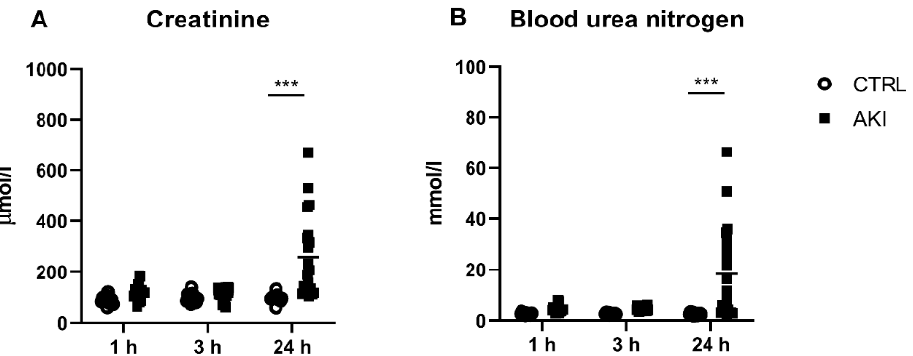
Figure 1. Concentrations of plasma creatinine ( A ) and urea ( B ) at different time points after AKI induction. *** denotes p ˂ 0.001. CTRL—control group; AKI—glycerol-induced acute kidney